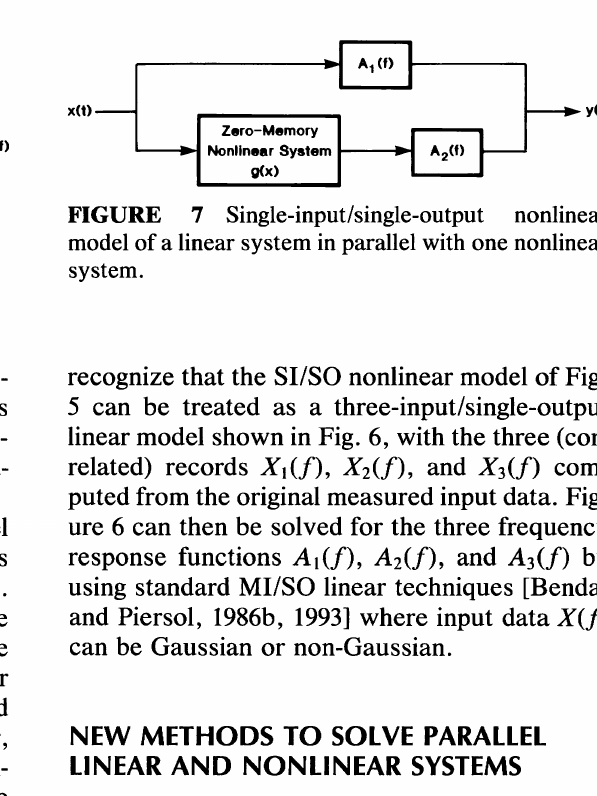
FIGURE 7 Single-input/singie-output nonlinear model of a linear system in parallel with one nonlinear